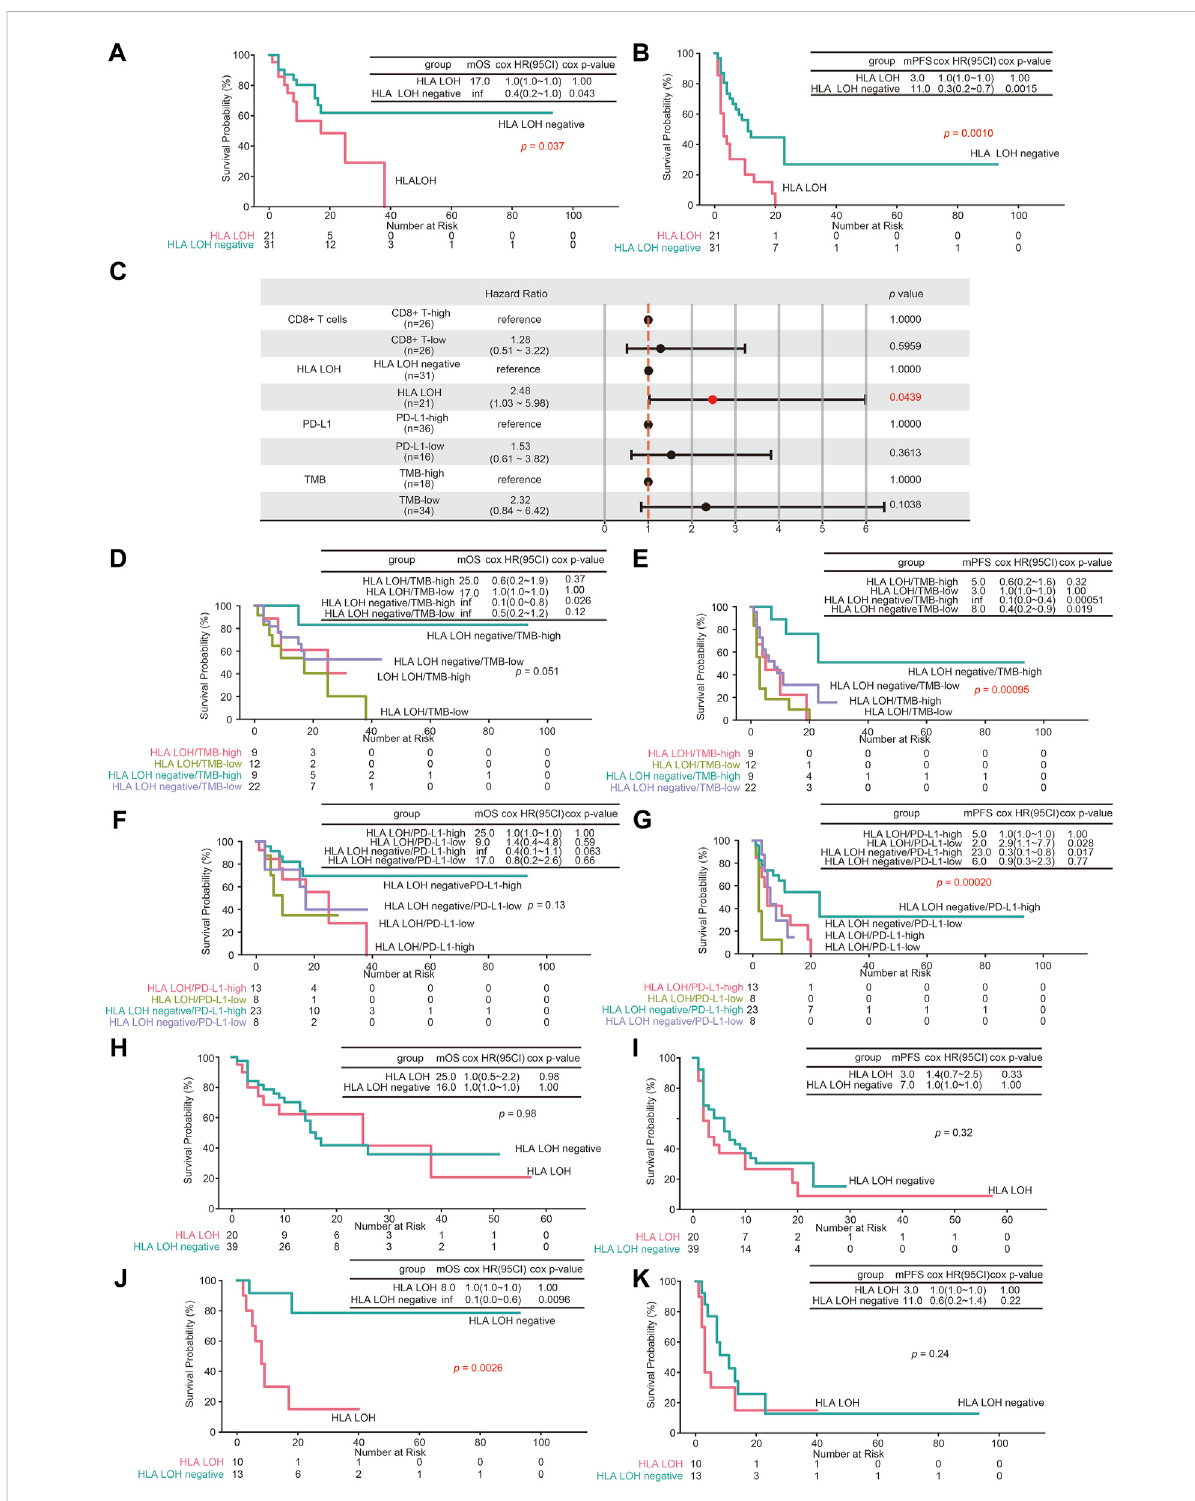
FIGURE 4 The predictive value of HLA LOH for ICIs treatment. (A , B) Kaplan – Meier curves of OS (A) and PFS (B) comparing HLA LOH negative with HLA LOH (C) The multivariate cox regression analyses of the HLA LOH, TMB, PD-L1and CD8 + T cells. (D , E) Kaplan – Meier curves of OS (D) and PFS (E) comparing groups of HLA LOH negative/TMB-high, HLA LOH negative/TMB-low, HLA LOH/TMB-high and HLA LOH/TMB-low (F , G) Kaplan – Meier curves of OS (F) and PFS (G) comparing groups of HLA LOH negative/PD-L1-high, HLA LOH negative/PD-L1-low, HLA LOH/PD-L1-high and HLA LOH/PD-L1-low (H , I) Kaplan – Meier curves of OS (H) and PFS (I) comparing HLA LOH negative with HLA LOH in LUAD patients (J , K) Kaplan – Meier curves of OS (J) and PFS (K) comparing HLA LOH negative with HLA LOH in LUSC